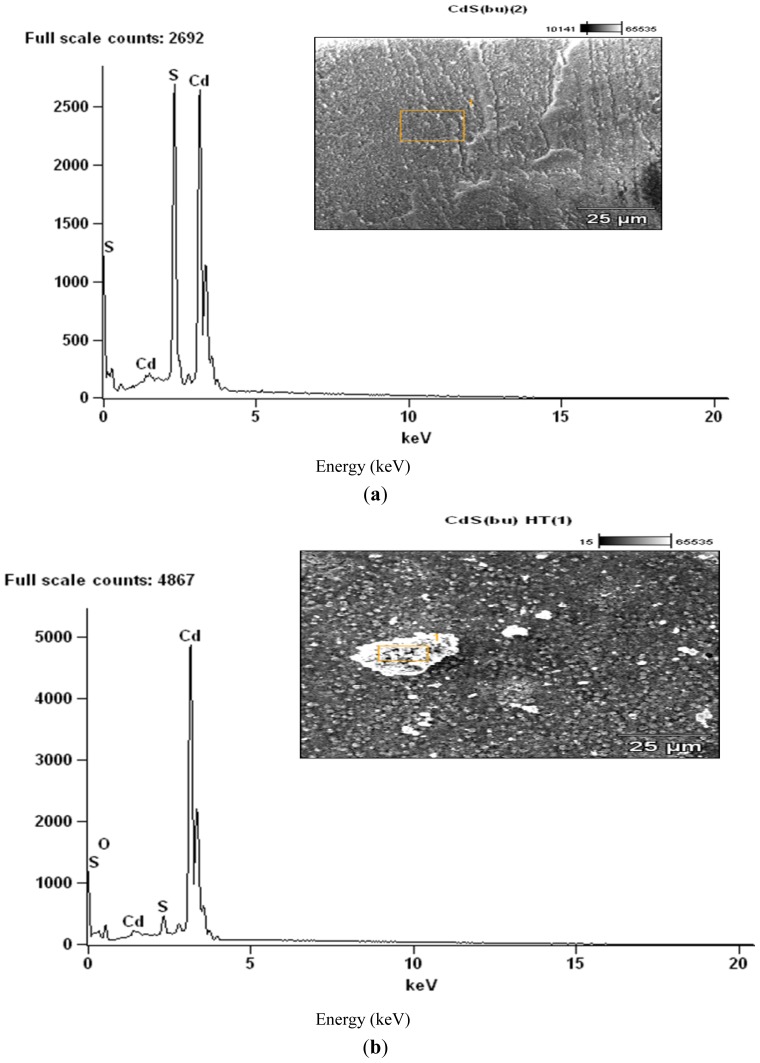
(a) EDX of the decomposed products from complex CdL22 at 400 °C; (b) EDX of the decomposed products from complex CdL22 at 800 °C.